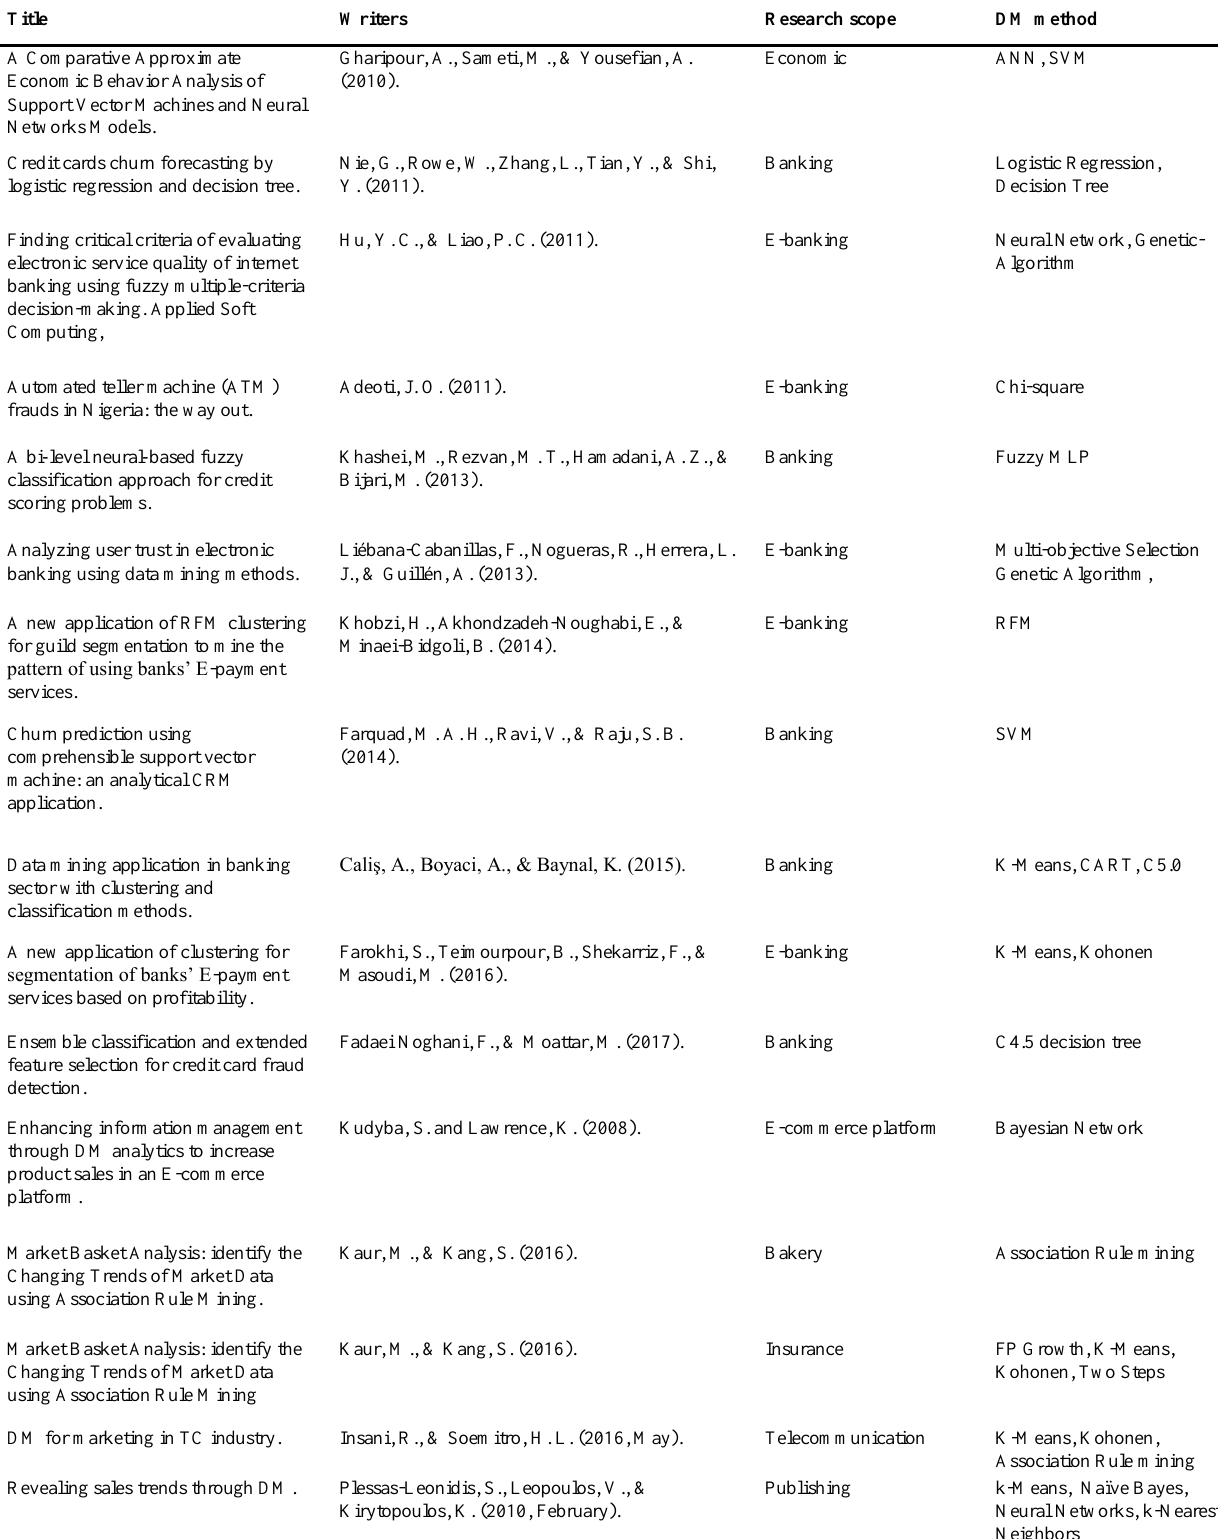
Table 1 . Summary of reviewed